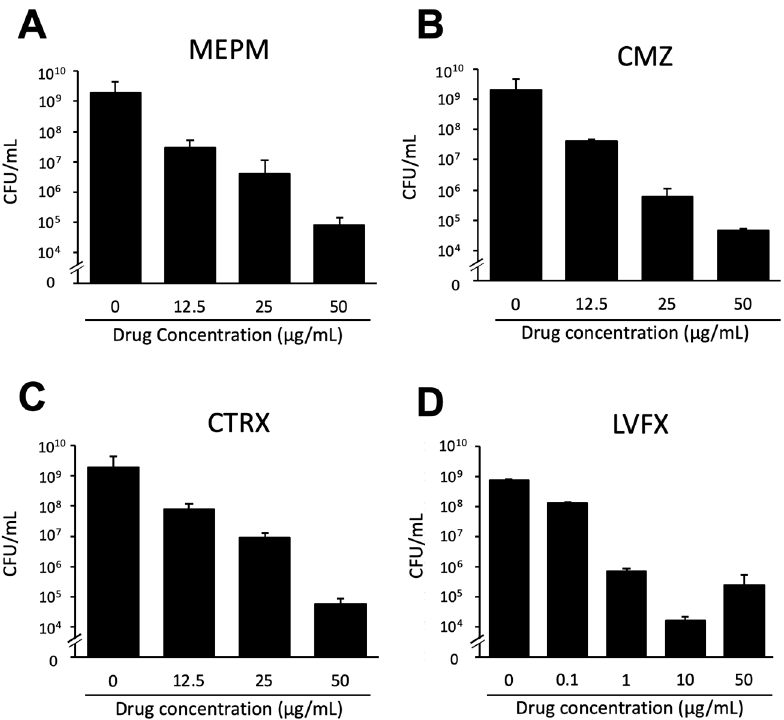
Figure 2. Drug susceptibilities of an E. coli RB-3 biofilm to four antibacterial agents. A high-capacity biofilm-forming strain, RB-3, was grown under biofilm-forming conditions for 24 h. Various concentrations of MEPM, CMZ, CTRX (0, 12.5, 25, and 50 µ g/mL), and LVFX (0, 0.1, 1.0, 10, and 50 µ g/mL) were added followed by incubation at 37 ◦ C for 24 h ( A – D ). The wells without drugs (0 µ g/mL) were used as controls. Then, the viable cells were counted. The data are the means ± standard deviations of three measurements. MEPM, meropenem; CMZ, cefmetazole; CTRX, ceftriaxone; LVFX, levofloxacin. Statistically significant differences between groups were evaluated using the Kruskal–Wallis test; p < 0.05. The p -value of each figure was less than